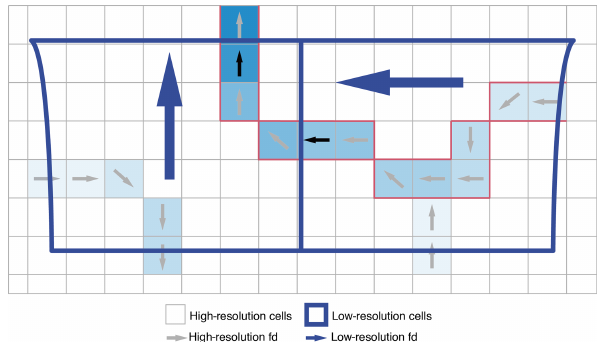
Figure 2. Sketch for the methodology to calculate river parameters from the HydroSHEDS high-resolution database to the 2.5km grid domain in